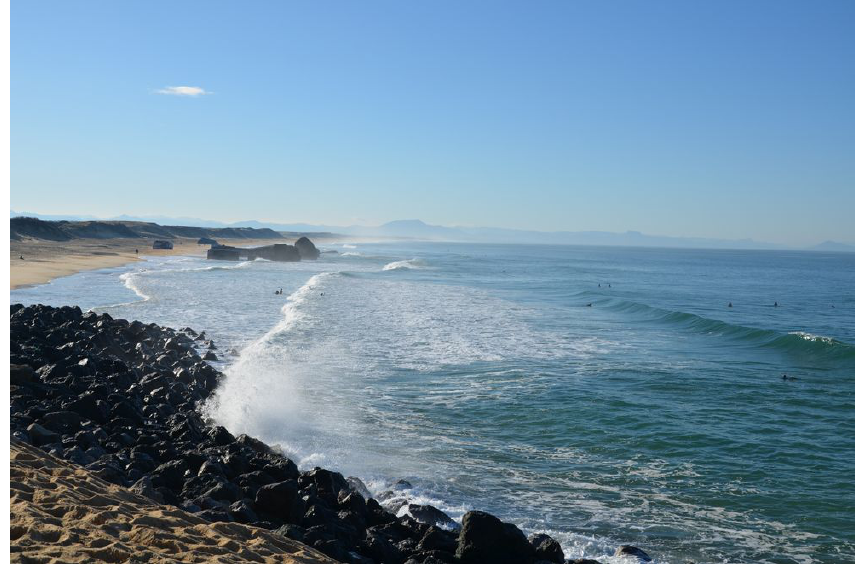
Figure 8. The beach La Piste at Capbreton, France.